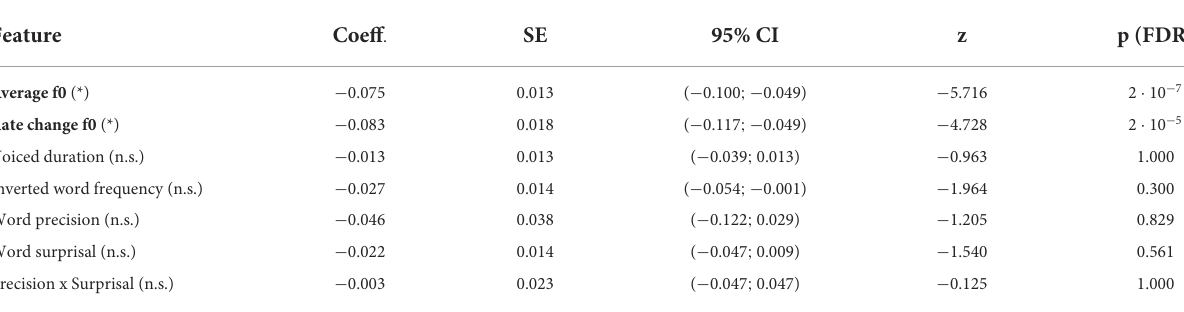
TABLE 1 Word-level modulation of the neural response to the fundamental